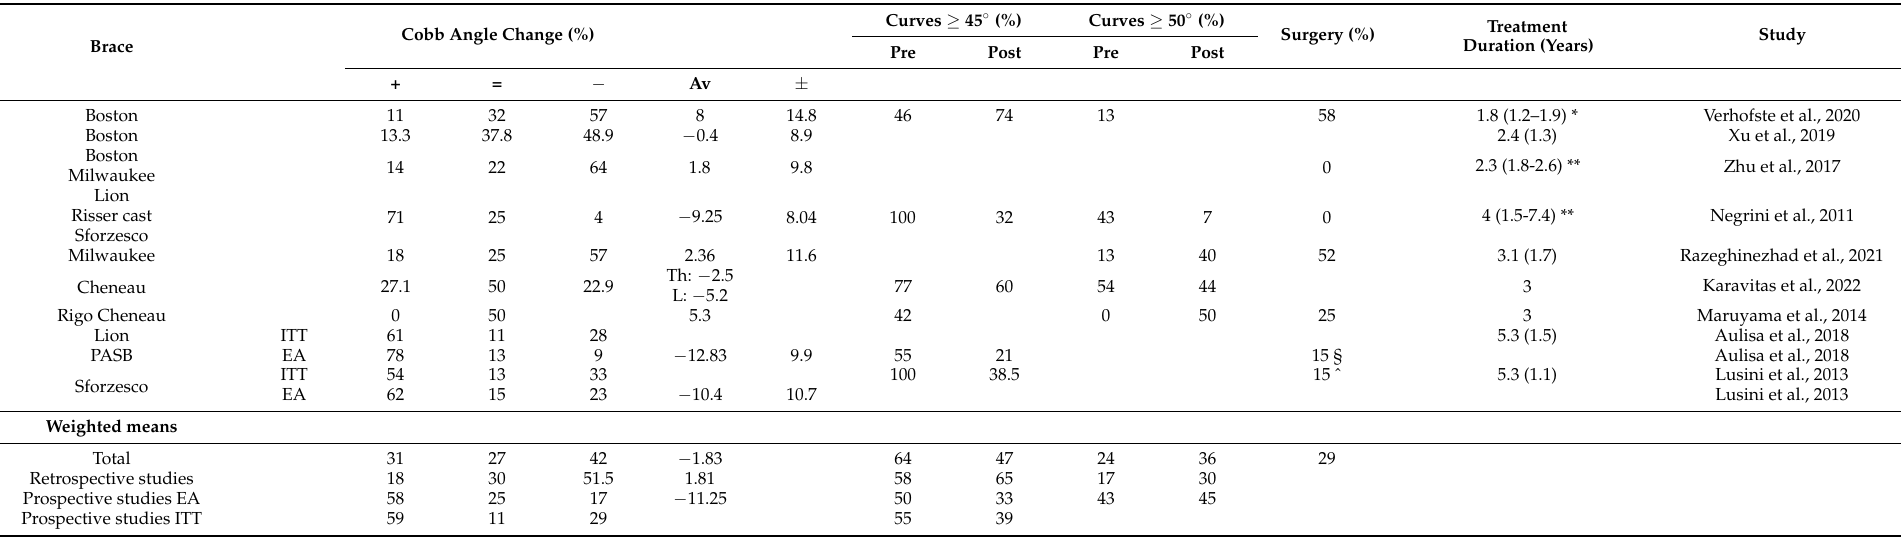
Table 3. Data provided by each included study on bracing